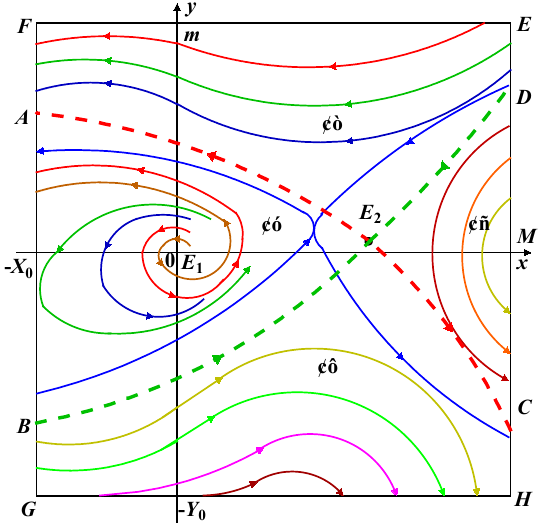
Figure 2. Unstable situation of the odd point E 1 (0, 0).